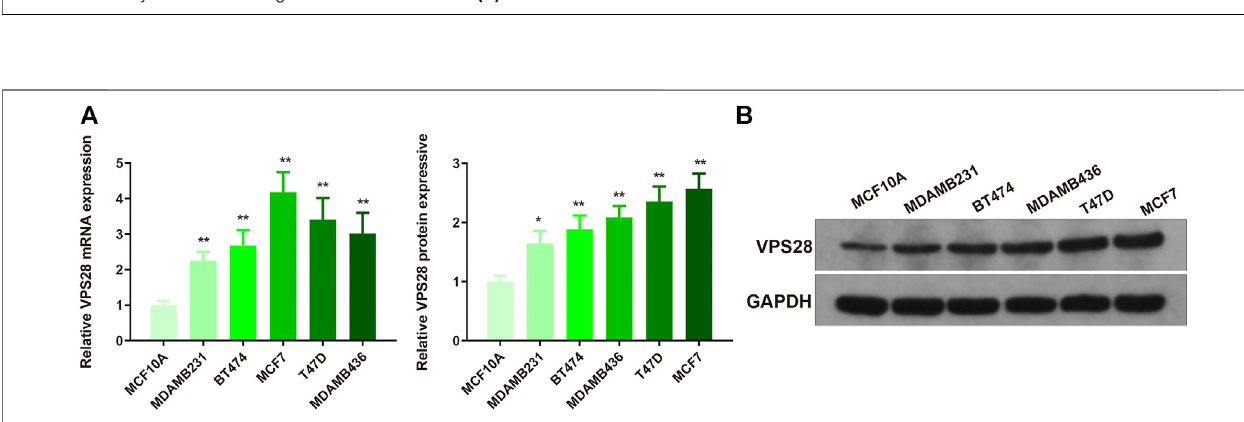
Frontiers in Molecular Biosciences |